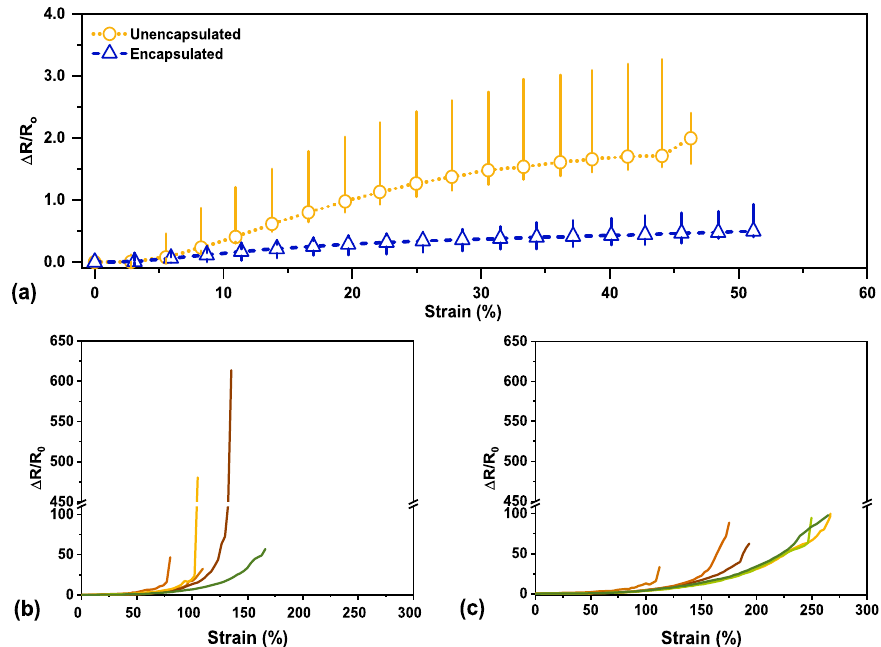
Figure 2. ( a ) Electromechanical response for unencapsulated and encapsulated sensors, respectively, tracks the normalized change in resistance ( Δ R/R 0 ) with applied strain. The marker indicates the median value with the bar depicting the range from minimum to maximum across N = 6. ( b ) Strain-to-failure behavior for each unencapsulated sensor, N = 6, and for each encapsulated sensor ( c ), N = 6, to study stretchability.